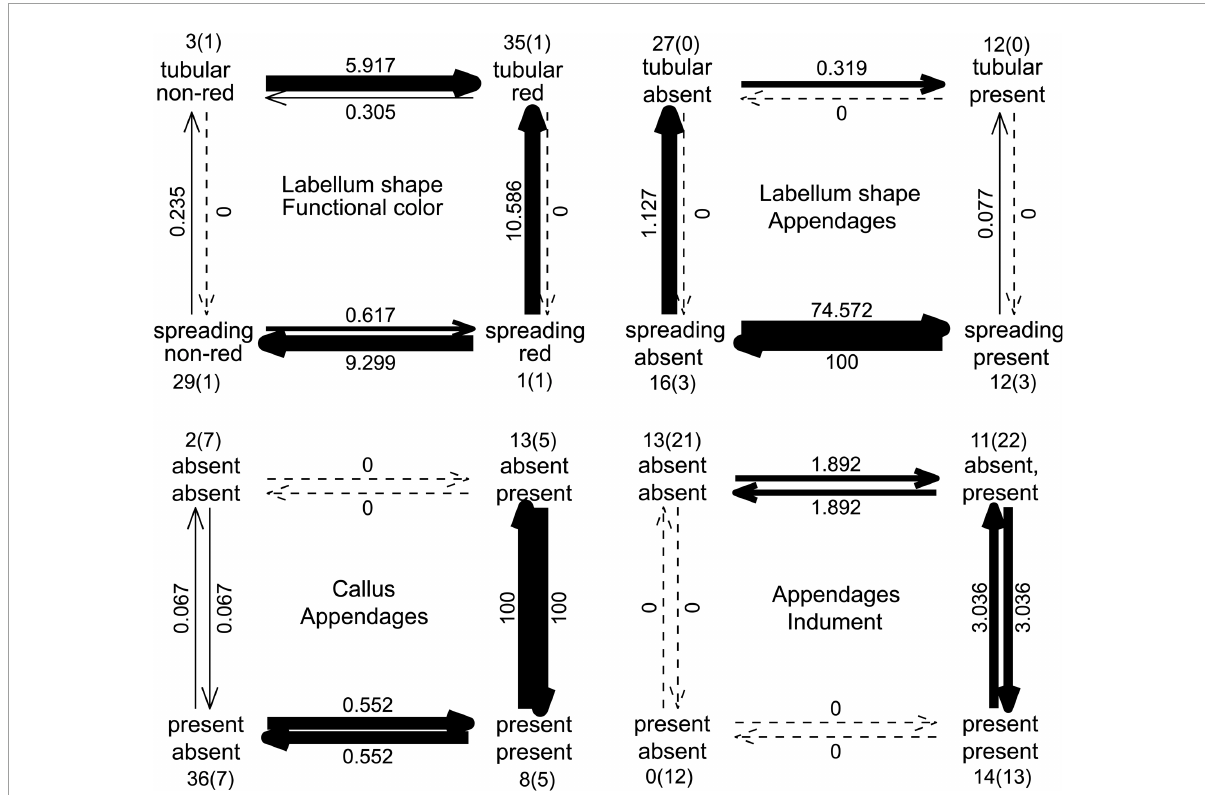
FIGURE5 Plot showing the transitions between the possible combinations of the character states in the models of correlated evolution for different pairs of traits. Thickness of the arrows is proportional to the values of the rates. Number of observations for each combination of characters are indicated. The number of additional observations involving a species presenting both states of one of the characters are shown in